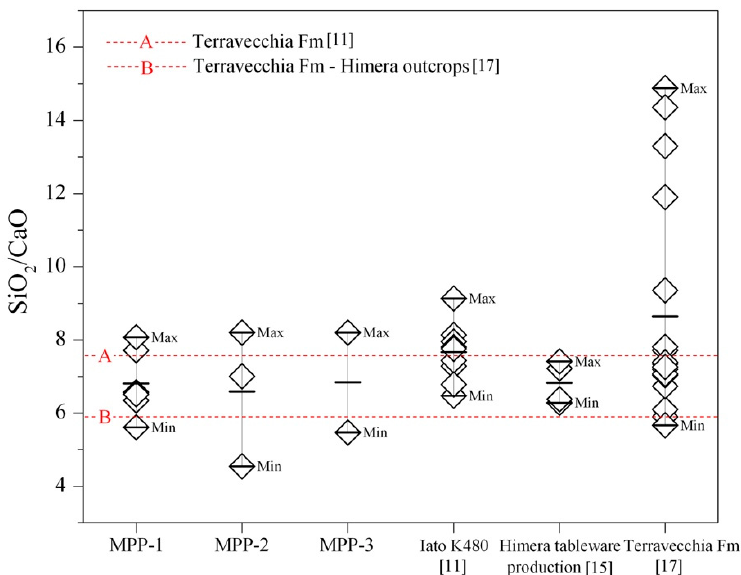
Figure 7. Box plot showing the variation intervals for SiO 2 / CaO ratio compared with those previously established for the productions of Himera.